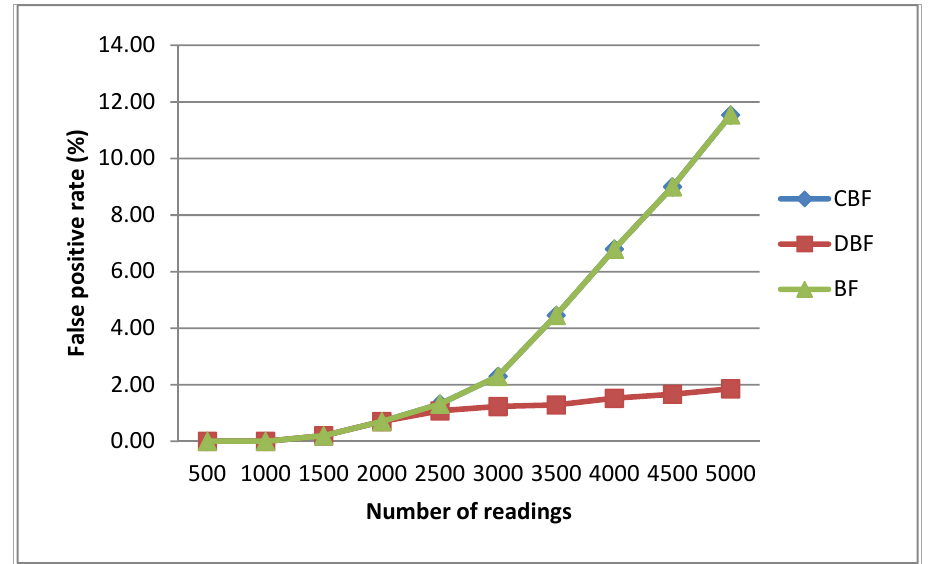
Figure 5. Comparison of FPR between Bloom filter